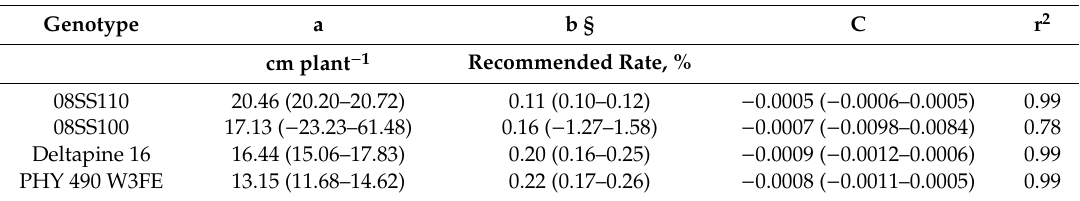
Figure 3. Interaction effect of nitrogen and genotype on plant height (PH) of cotton at 30 days after planting. Data are means ± Standard error ( n = 16 plants in total for fourreplications and two runs). Table 5. Quadratic equation constants and coefficient of determination for plant height of four cotton genotypes to nitrogen treatment at 30 days after planting.